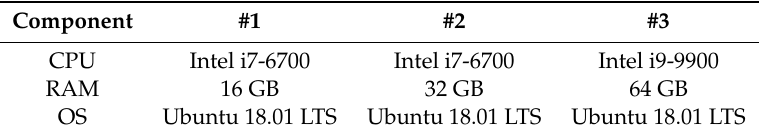
Table 5. Experiment environments.